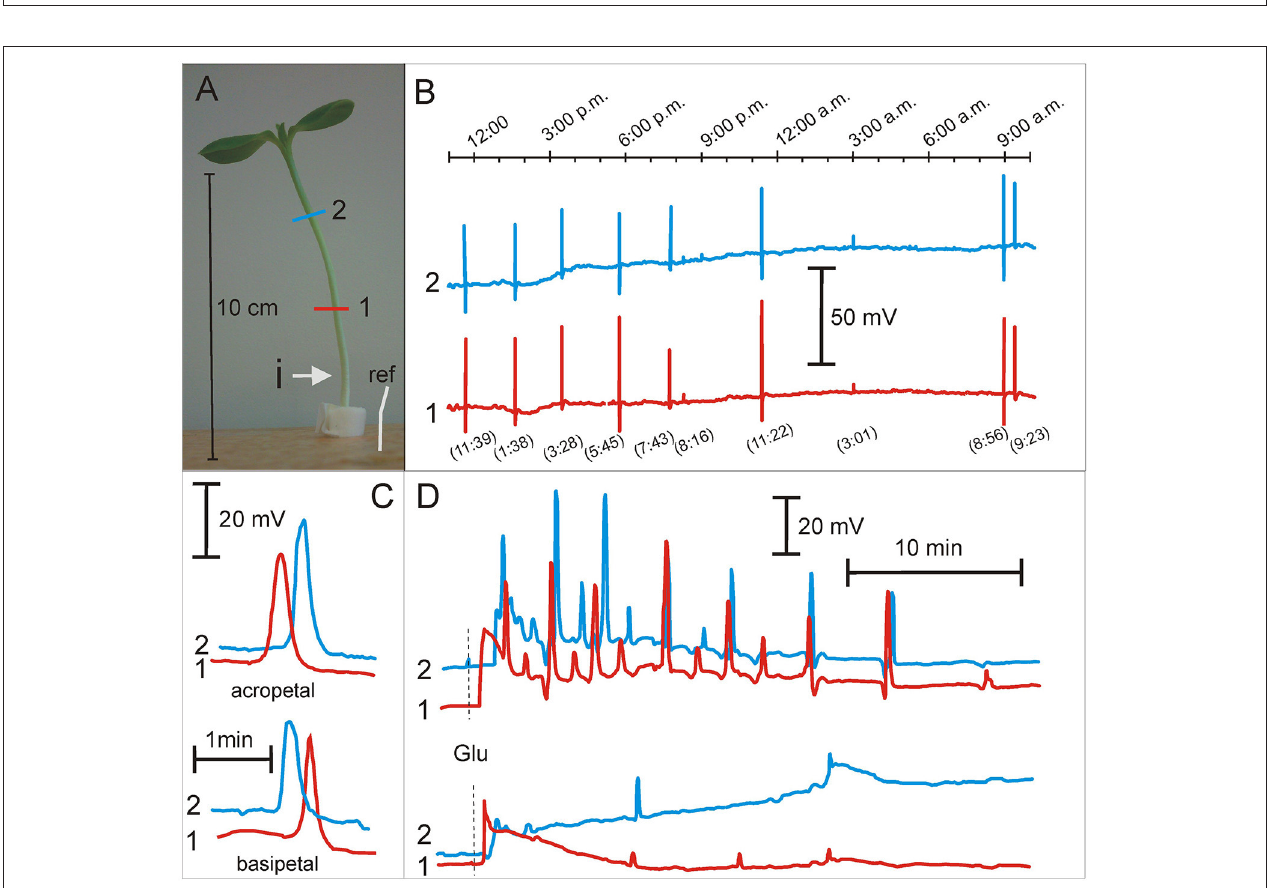
FIGURE 2 | Spontaneous action potentials and glutamate induced series of action potentials in Helianthus annuus seedlings under osmotic and salt stresses. (A) Helianthus annuus seedlings, electrode arrangement (1, 2, ref—reference electrode) and site of glutamate injection (i). (B) Example of recordings of spontaneous action potentials during 1 day (also shown in Supplementary Video S2). In the parentheses, the time of SAP appearing. (C) Example of recordings of acropetally and basipetally propagating spontaneous action potentials. (D) Example of recordings of action potential series after glutamate (Glu) injection into the hypocotyl base of seedlings growing under 80mM KCl (upper) as well as 160mM NaCl nutrient solutions (lower). Data details are presented in Tables 1 , 2